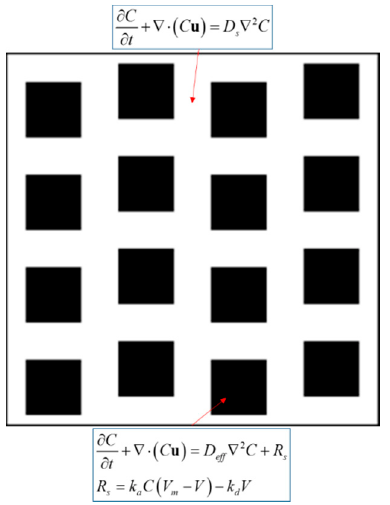
Figure 4. The simplified 2D reconstructed geometry of the coal matrix.